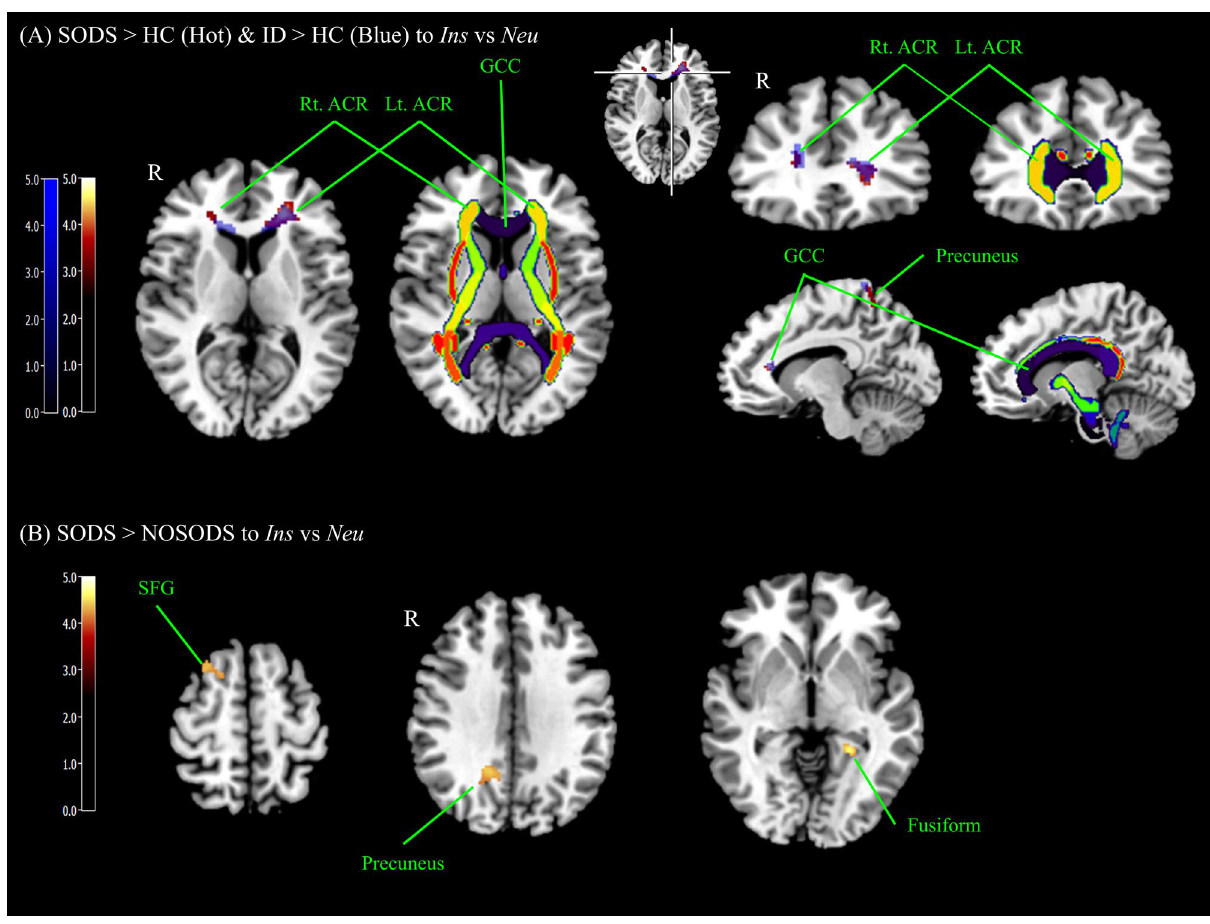
Figure 1. Brain areas showing significantly increased BOLD signals in the contrast of Ins vs. Neu among groups. ( A ) Brain areas showing increased BOLD signals to the contrast of Ins vs. Neu among groups (SODS vs. NOSODS vs. HC; ID vs. HC). Brain areas showing increased BOLD signals to the contrast of Ins vs. Neu in SODS and ID compared to HC group were GCC and bilateral ACR and precuneus. There were no significant areas in NOSODS compared to the HC group. ( B ) In the SODS group compared to the NOSODS group, right SFG, left fusiform, and right precuneus showed a statistically significant difference in the contrast of Ins vs. Neu . The statistical threshold was voxel-wise uncorrected p < 0.001 with cluster-wise FWE corrected p < 0.05 (141 voxels). SODS insomnia with subjective–objective discrepancy of sleep group, NOSODS insomnia without subjective–objective discrepancy of sleep group, HC healthy control, ID insomnia disorder group (SODS + NOSODS), Ins insomnia item, Neu neutral item, GCC genu of corpus callosum, ACR anterior corona radiate, SFG superior frontal gyrus, FEW family wise